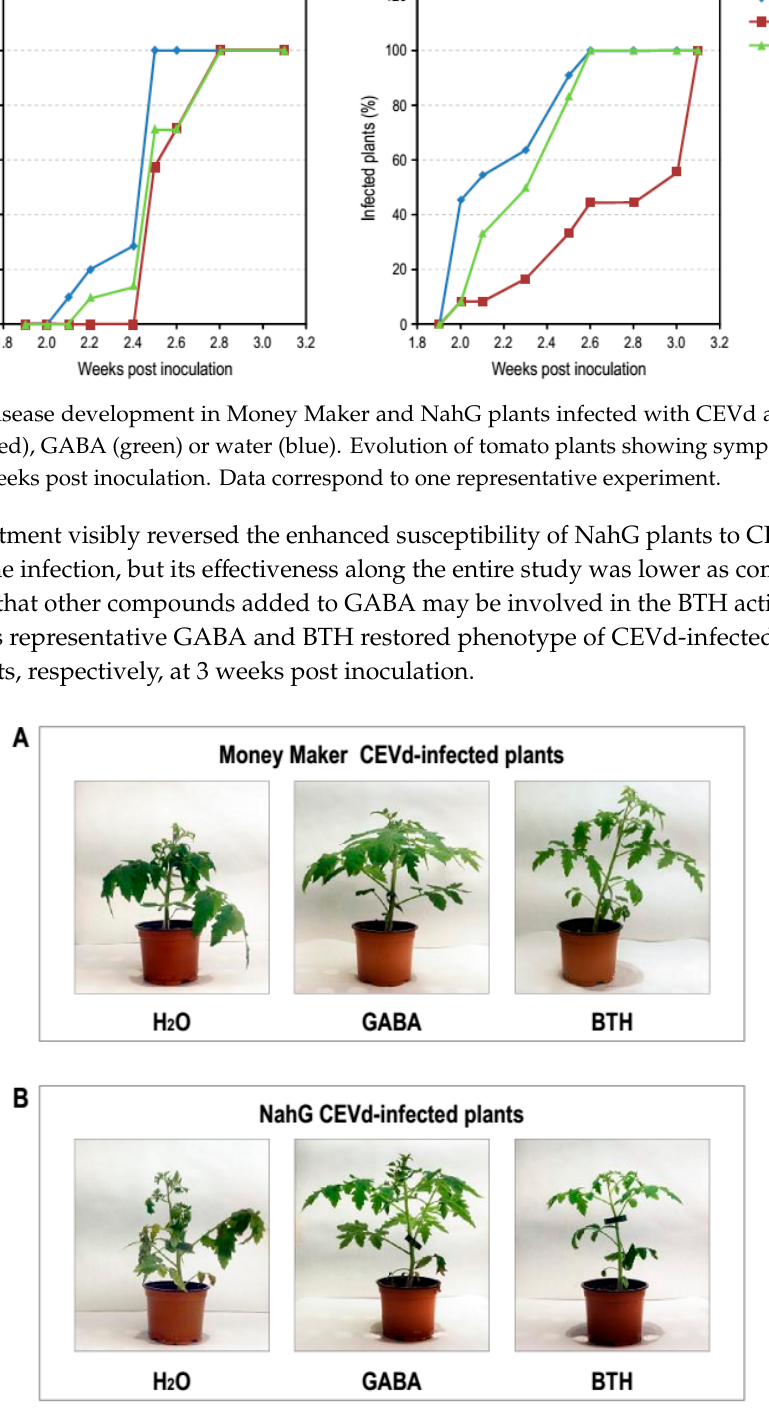
Figure 7. Growth of ( A ) Money Maker and ( B ) NahG plants following treatment with GABA or BTH and CEVd inoculation. Representative phenotype observed un infected plants 3 weeks after CEVd inoculation, and in equivalent plants pre-treated with 1 mM GABA or 1 mM BTH.